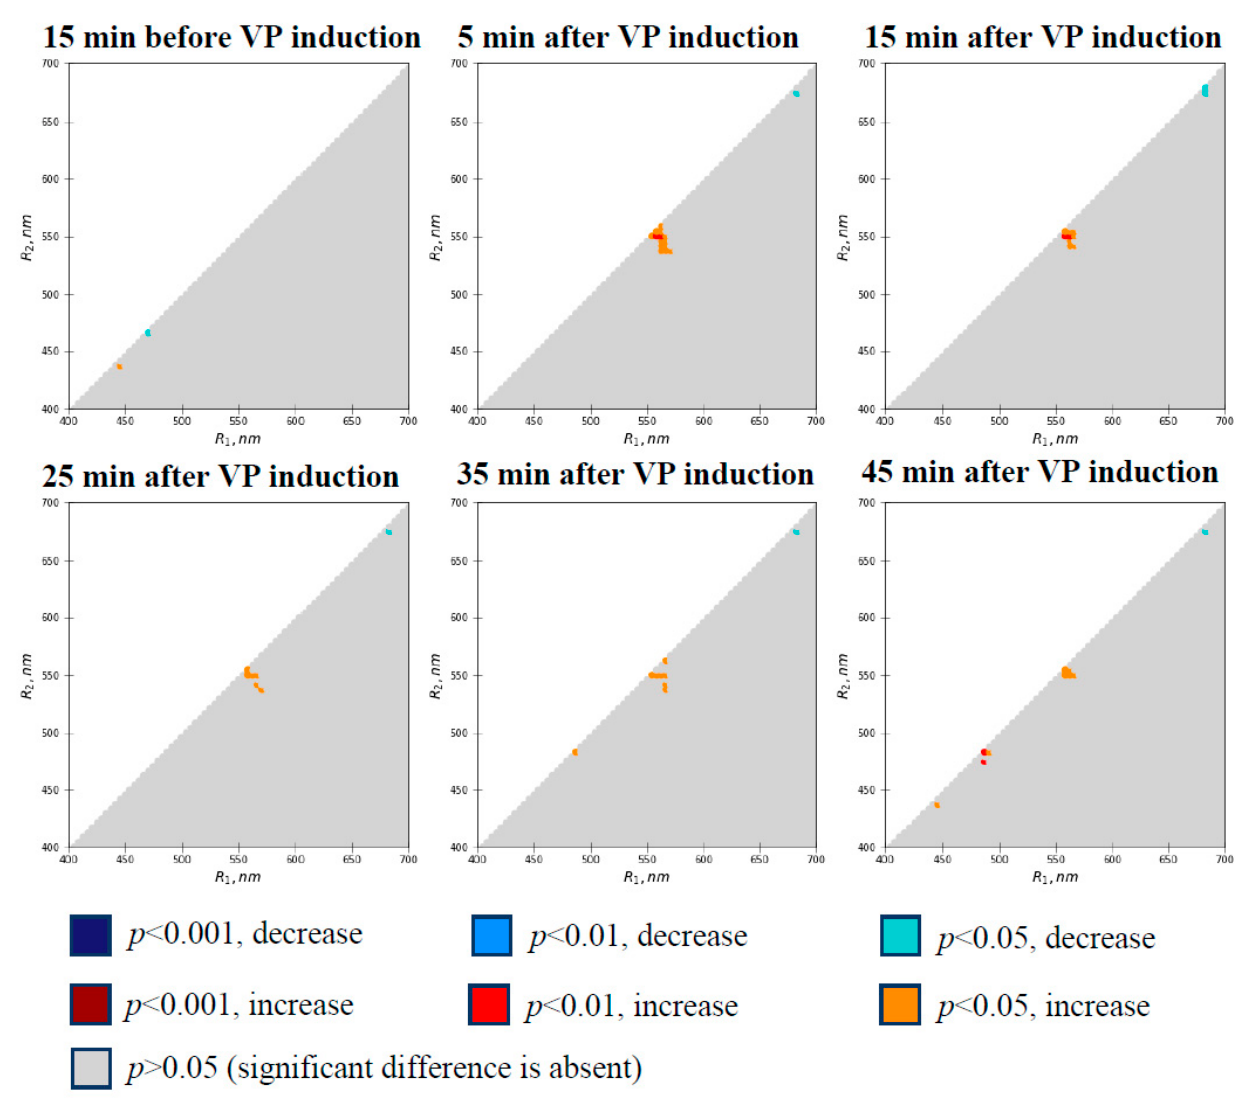
Figure 2. Heat maps of significance and directions of changes in absolute values of RIs in the second pea leaf at different time intervals before and after induction of variation potential ( n = 13). RIs were calculated based on Equation (1). Burning of the first leaf was used for VP induction. The Mann–Whitney U test was used for p -value calculations. The absolute values of RIs were compared to the values of RIs at 5 min before VP induction.